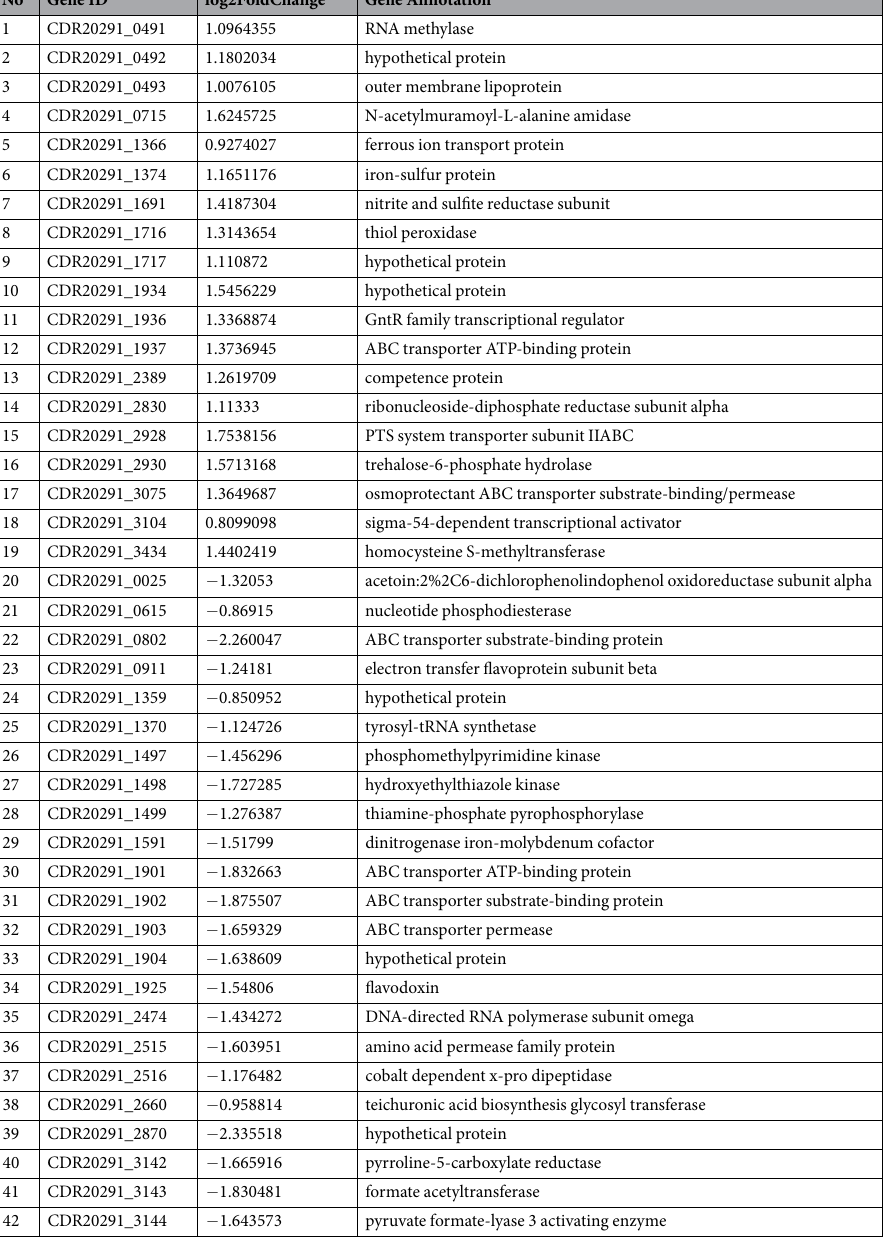
Table 3. Genes up and down-regulated in luxS during co-culture with B . fragilis relative to the WT C . difficile monoculture. Note: P-adjusted value ≤